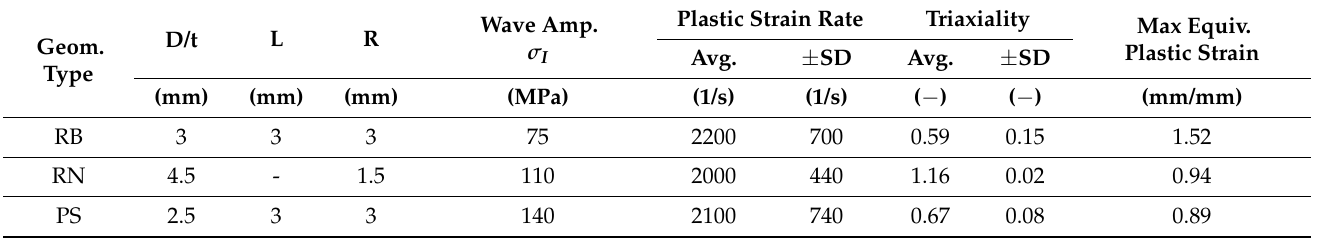
Table 2. Optimized geometric parameters and predicted results.